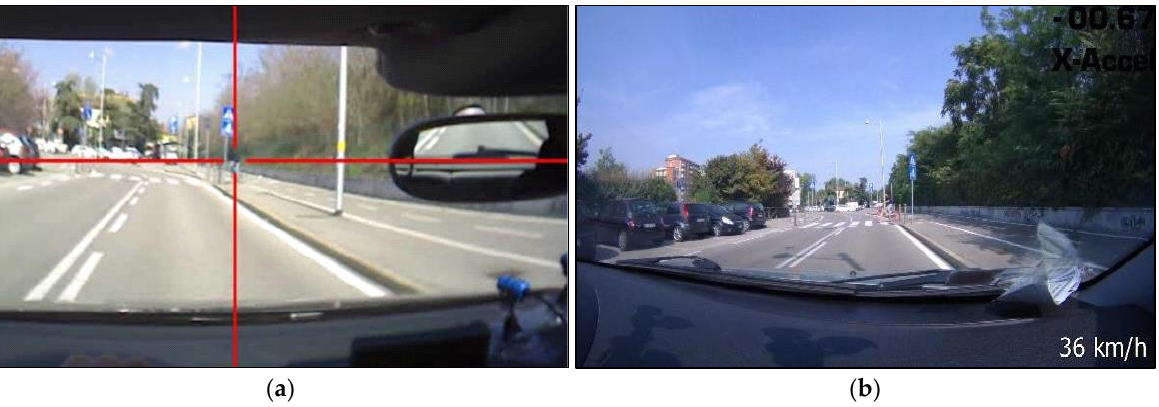
Figure 4. Synchronization of the eye-tracking mobile video output with the Video VBOX video output. ( a ) Video of the ME with the point of fixation (red cross), ( b ) Video of Video VBOX.